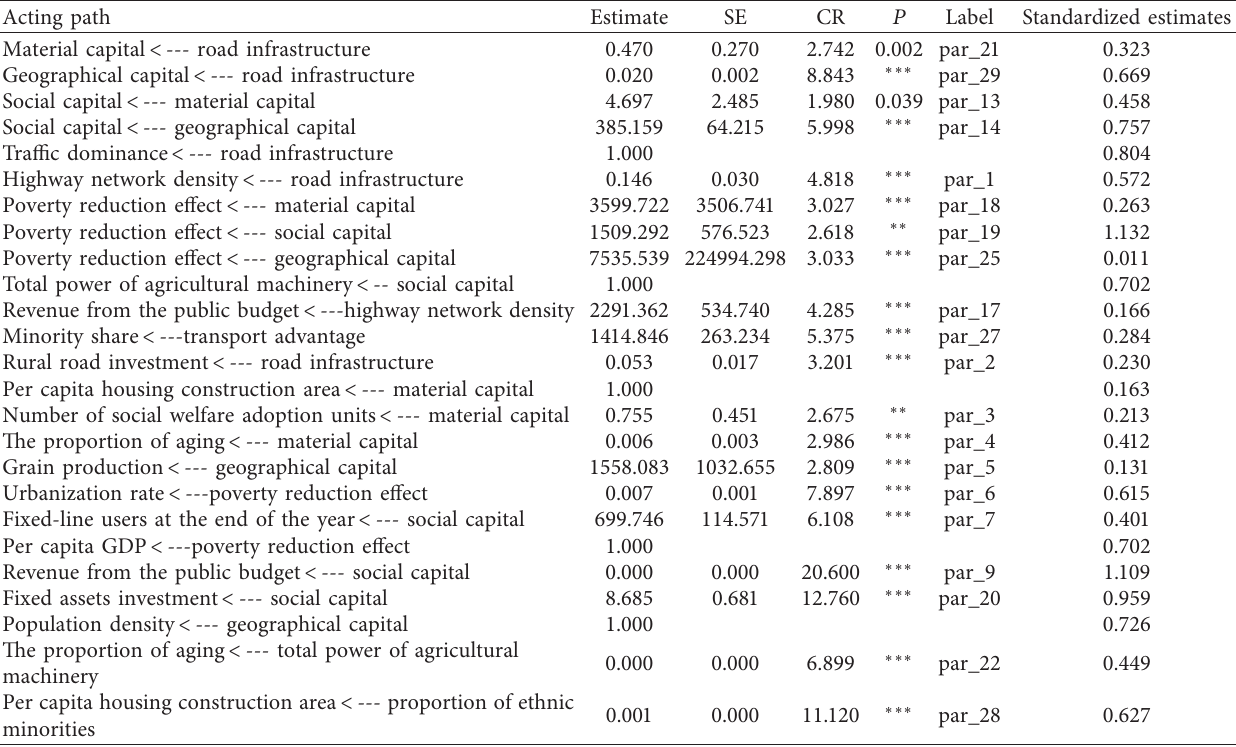
Table 3: Estimation results of the variable coefficient and significance test.